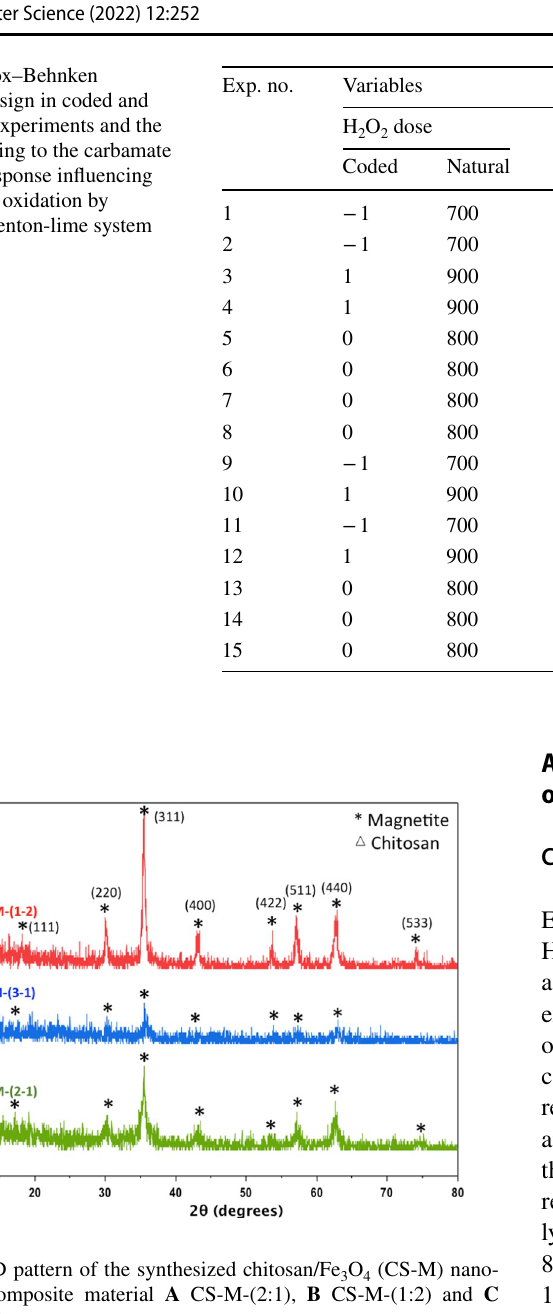
3 O 4 (CS-M) nano-